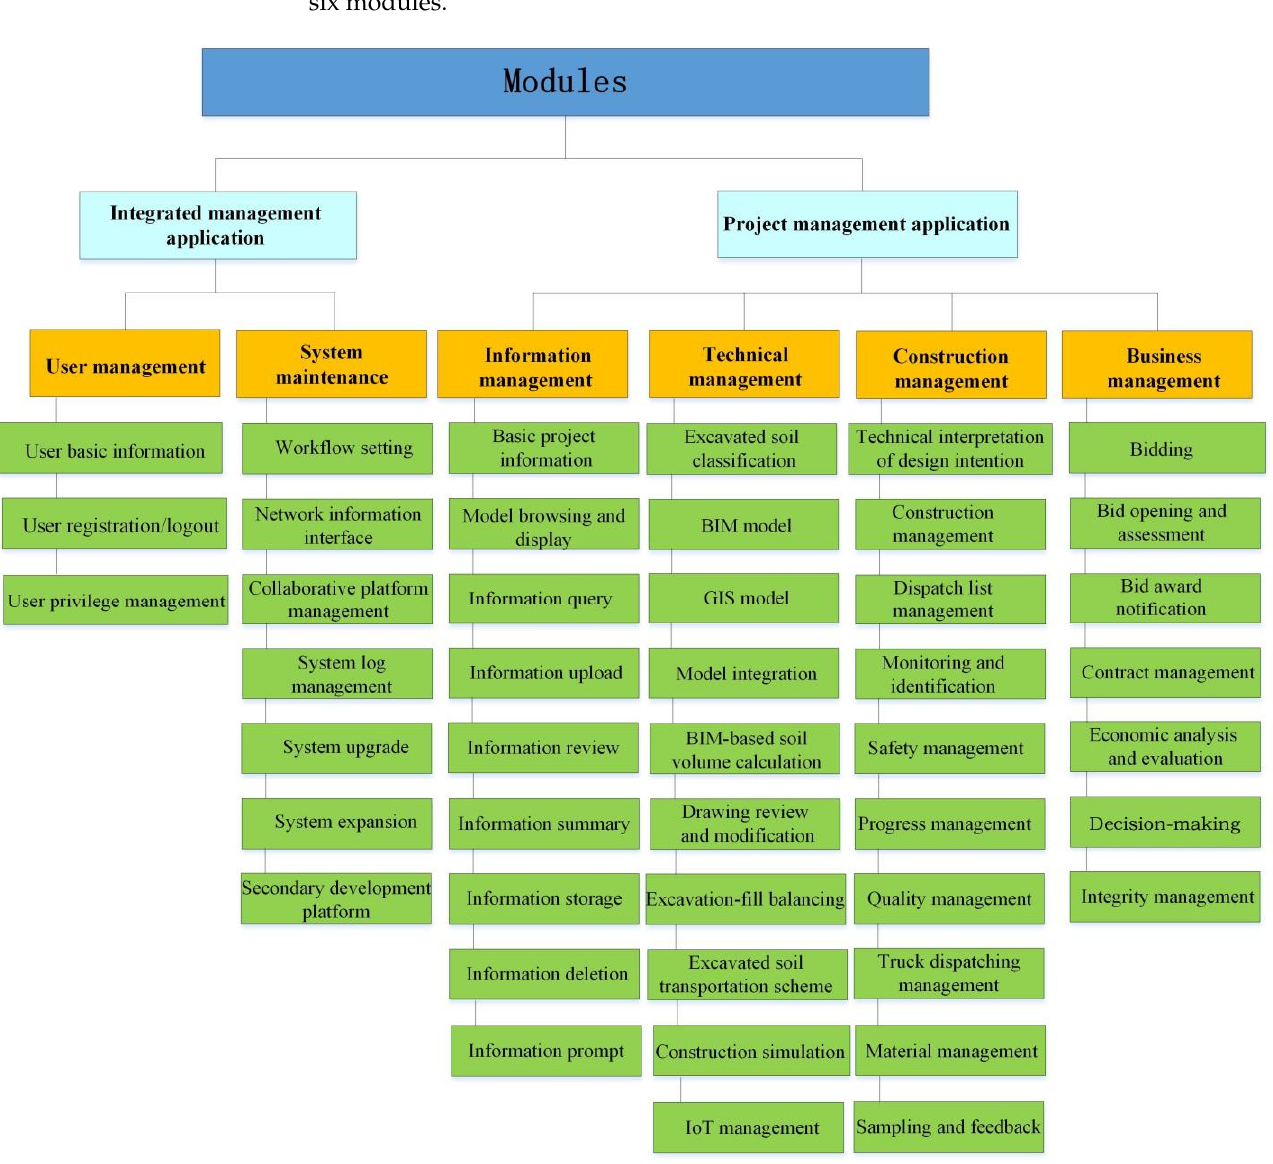
Figure 2. The modules and main functions of the BIM-GIS-IoT-based excavated soil recycling sys- tem.